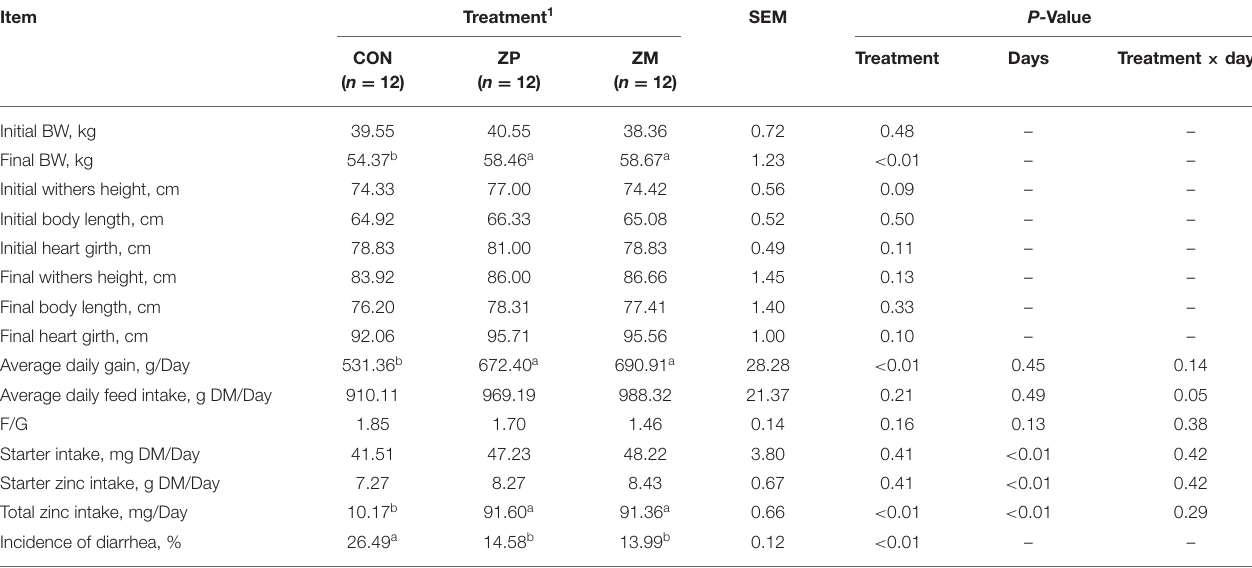
TABLE 3 | Effects of organic zinc sources on the body size measurement, growth performance and incidence of diarrhea in dairy calves during the first month of life (Experiment 2).